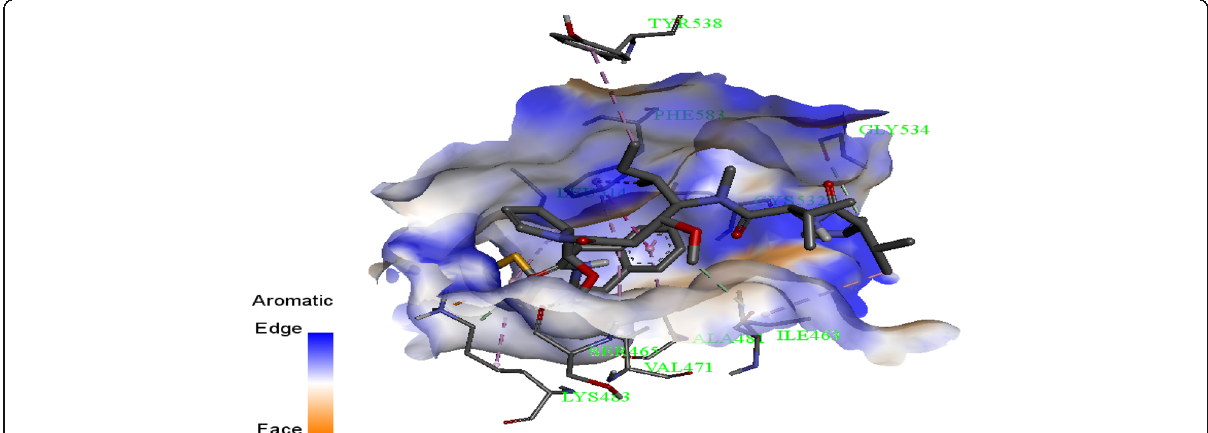
Fig. 4 3D diagram of the interaction between compound 39 with